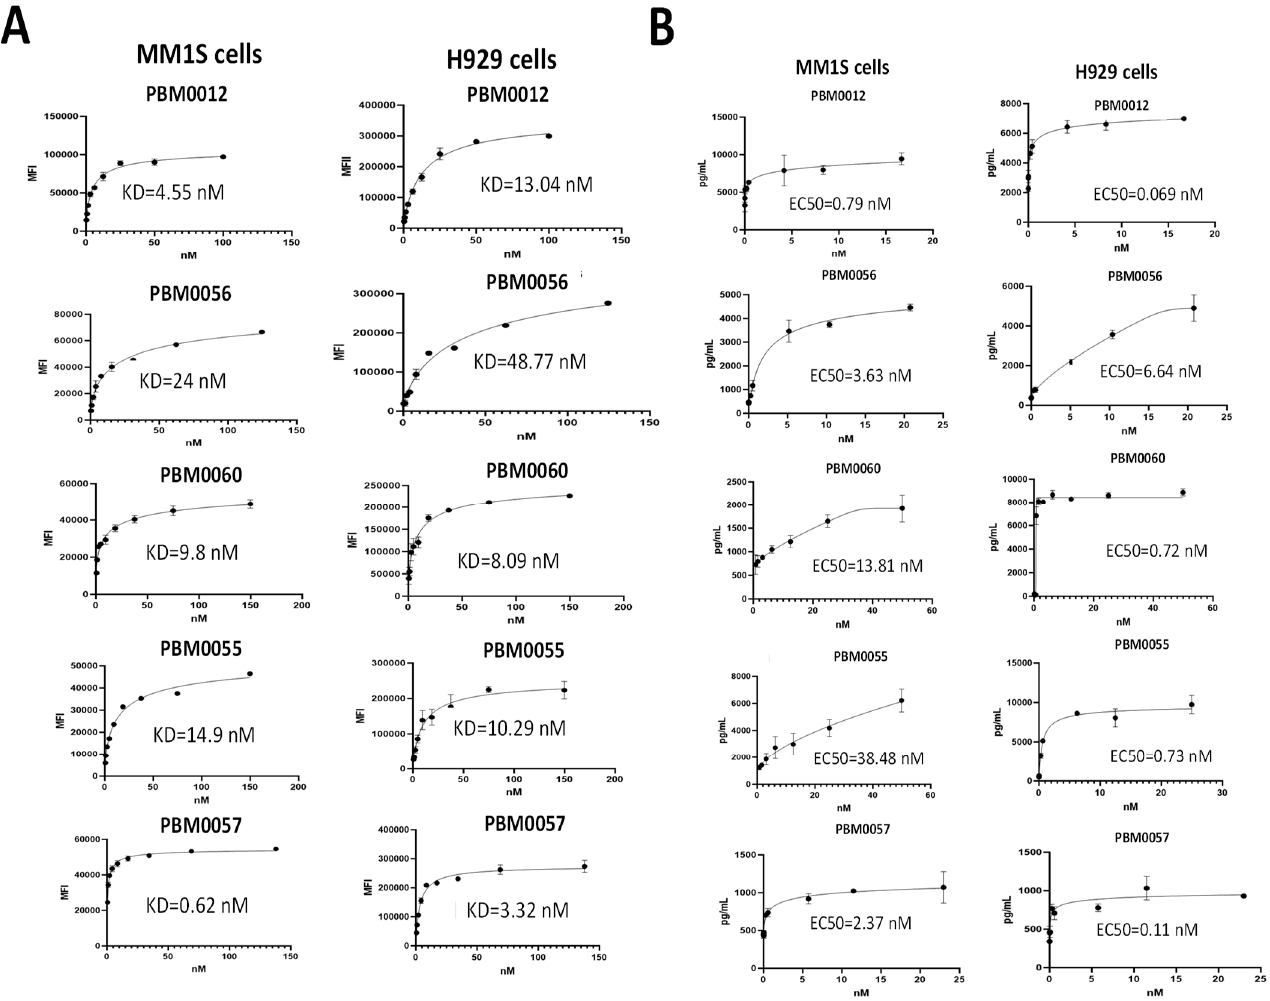
Figure 4. ( A ) BCMA-CD3 antibodies bind multiple myeloma cell lines and all bispecific antibodies with T cells secrete IFN-gamma. ( A ) Representative FACS assay with MM1S and H929 cells is shown. ( B ) BCMA-CD3 antibodies and T cells secrete IFN-gamma with multiple myeloma cells. Representative assay is shown. Bars show standard deviations from three independent measurements.